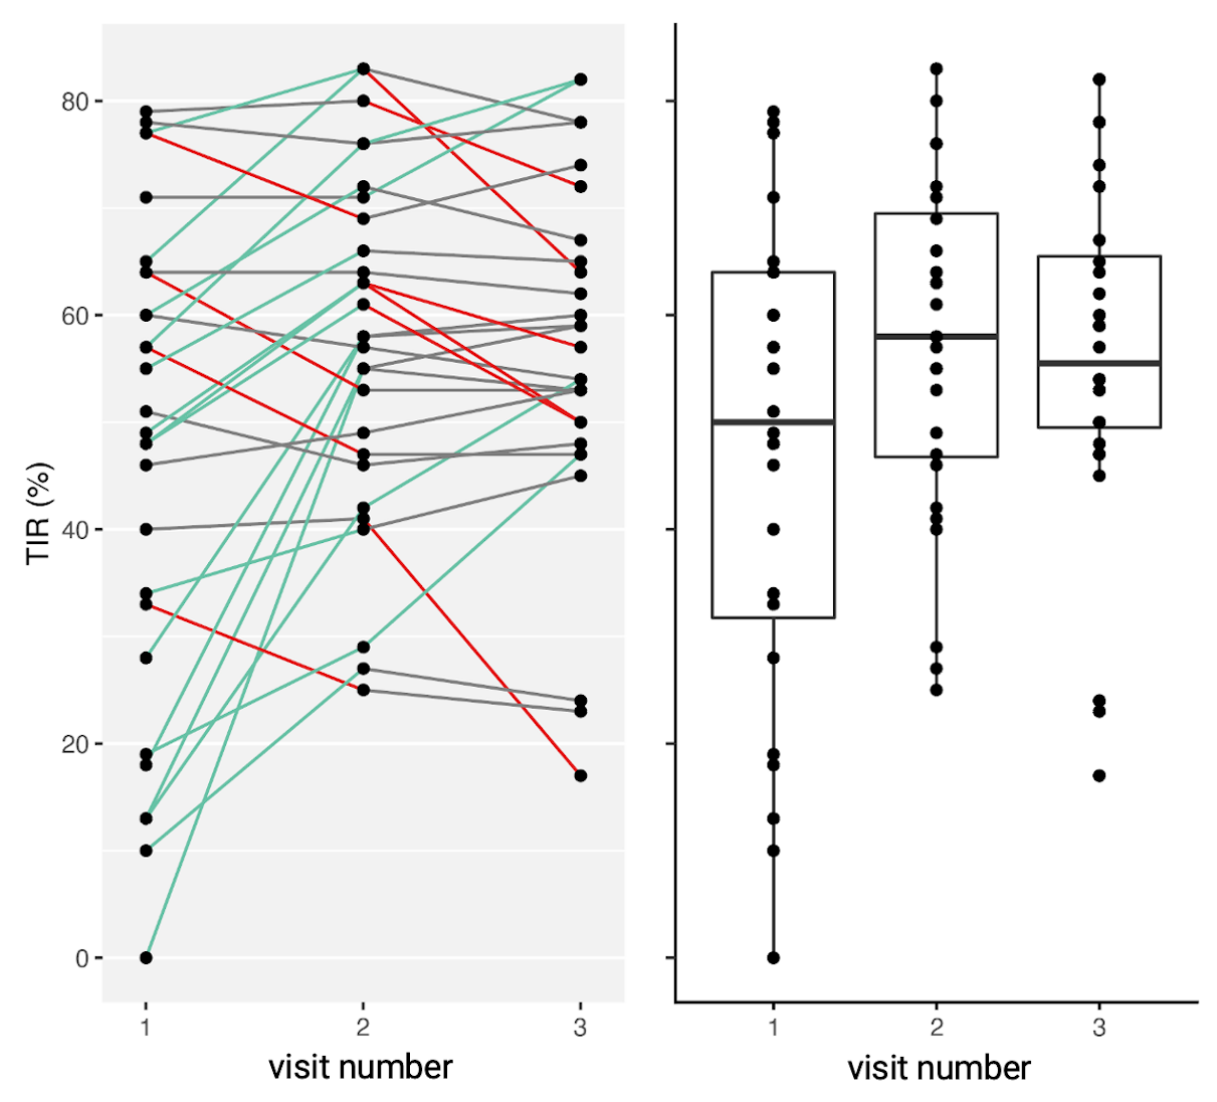
Figure 6. The individual changes and overall distribution of participants’ percent TIR of sensor glucose targets before remote consultations (ie, visit 1), after 3 months of remote consultations (ie, visit 2), and after 6 months of remote consultations (ie, visit 3). Green lines indicate that the individual change in TIR was >5% (ie, high amount of change). Red lines indicate that the individual change in TIR was <5% (ie, low amount of change). Grey lines indicate that the individual change in TIR was within 5% of the acceptable range (ie, a stable TIR). TIR: time in